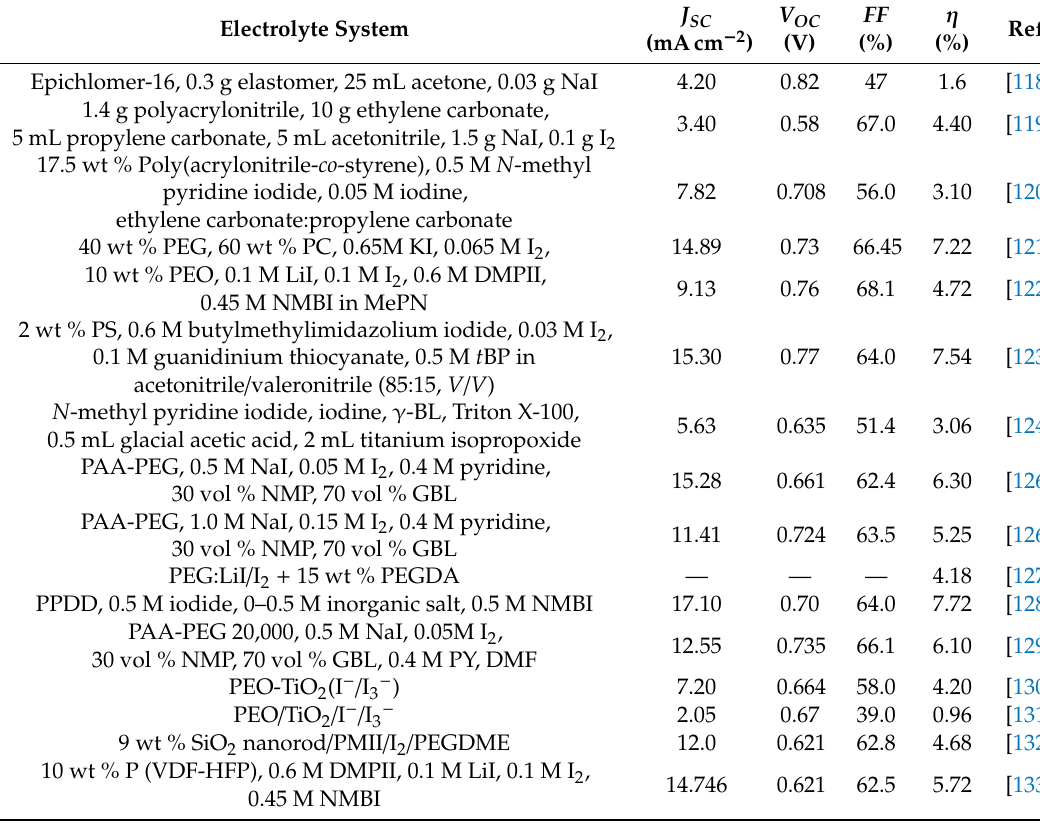
Table 5. Photovoltaic performance parameters of DSSCs based on the di ff erent polymer electrolyte. Electrolyte